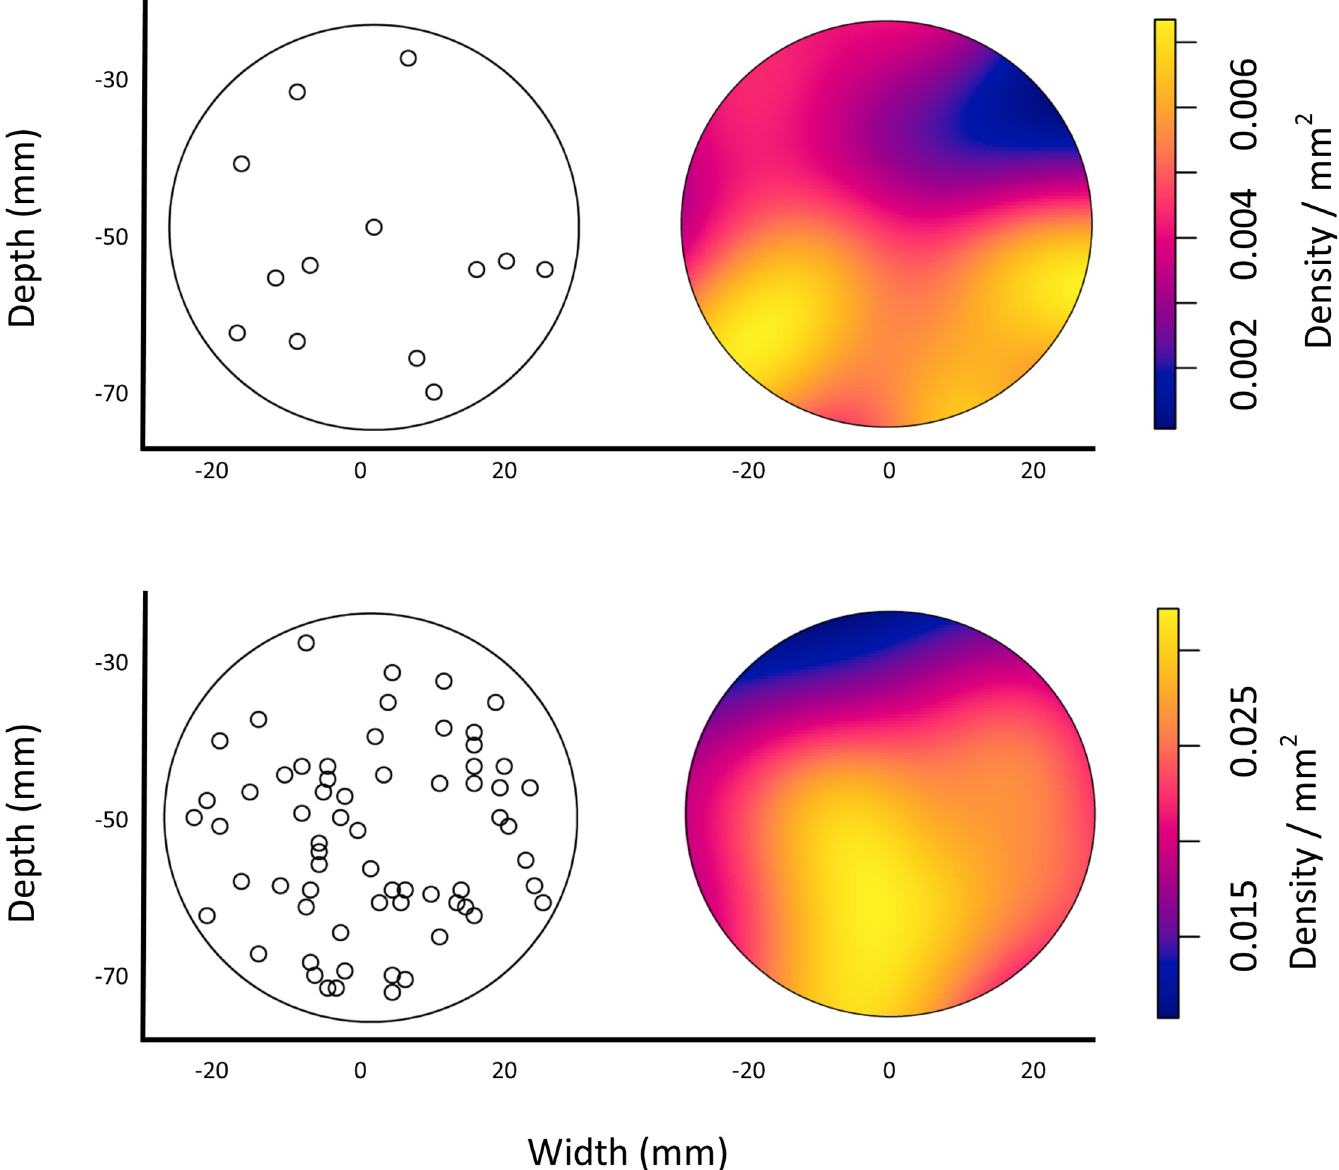
Fig 4. Spatial distribution of penetration events within the test apparatus for premature (n = 13) and primary (n = 65) failure modes.